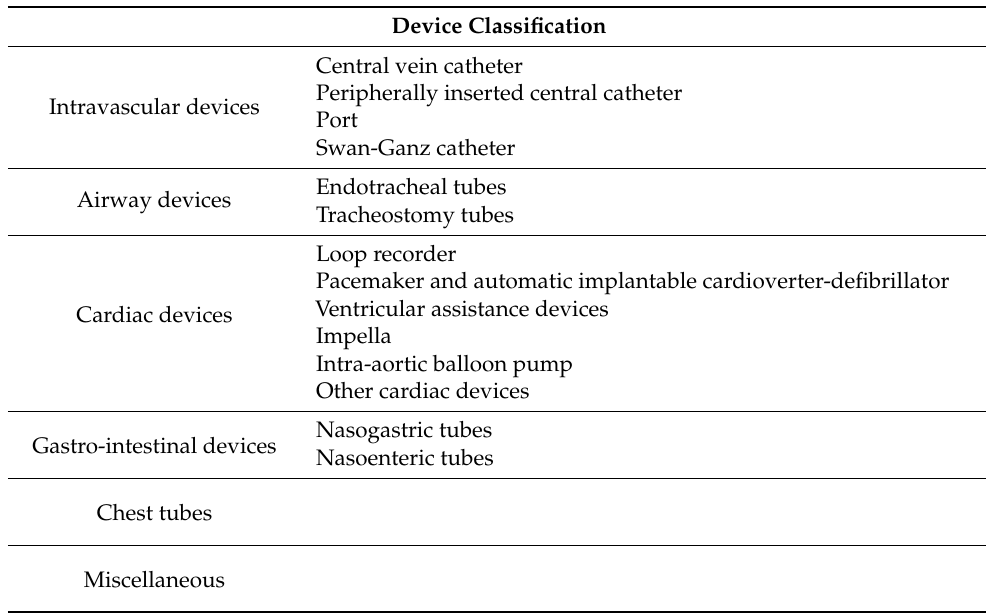
Table 1. Anatomical-based classification of chest